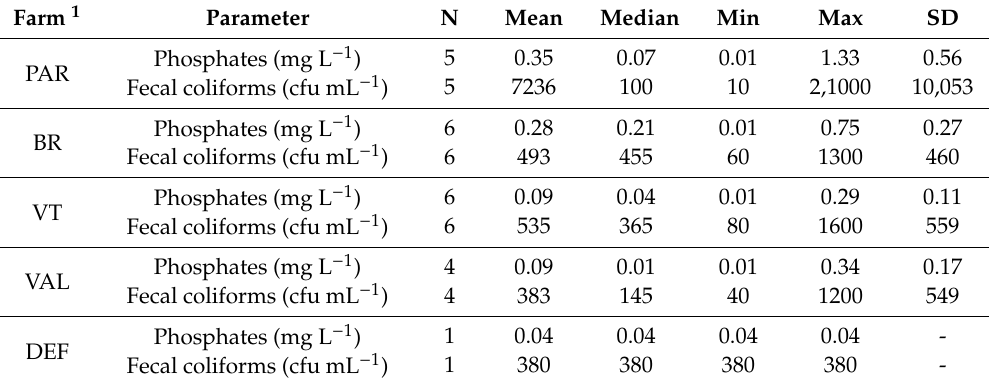
Table 2. Main descriptive statistics of the parameters of water quality by